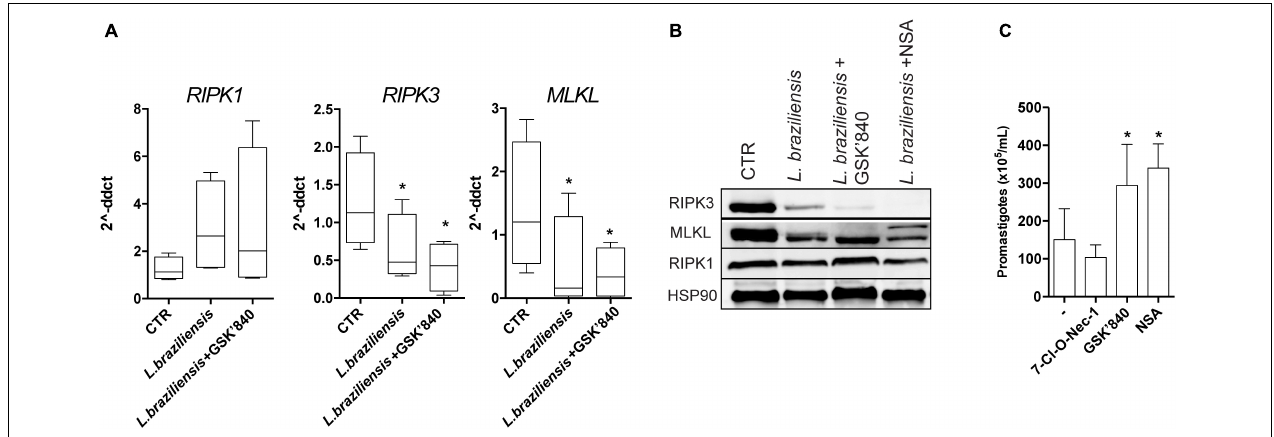
FIGURE 2 | RIPK3-, but not RIPK1-mediated necroptosis, restrains Leishmania growth inside macrophages. PMA-differentiated THP-1 cells were pretreated with the indicated inhibitors for 1 h, followed by infection with L. braziliensis for 24 h. (A) RIPK1, RIPK3, and MLKL from macrophages was determined by real-time PCR. (B) RIPK1, RIPK3, and MLKL protein expression was determined by Western blot. HSP90 was used as a loading control. (C) PMA-differentiated THP-1 cells were pretreated with the indicated inhibitors for 1 h, followed by infection with L. braziliensis . The parasite load was measured by the counting of viable promastigotes as described in the Section “Patients and Methods.” Lines and boxes represent medians and interquartile ranges, and whiskers represent minimum and maximum values. Three independent experiments were performed. Values were compared by the Kruskal–Wallis test with Dunn’s multiple comparisons post-test. ∗ P < 0.05.